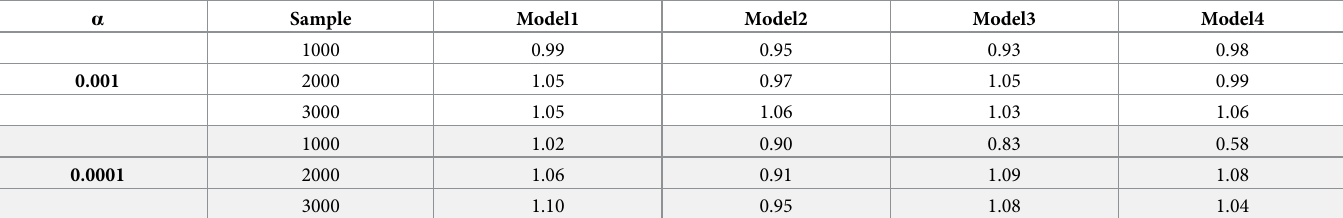
Table 2. The estimated type I error rates divided by the nominal significance levels of the ceCLC method for 10 quantitative and 10 qualitative phenotypes with 10 6 replications. α